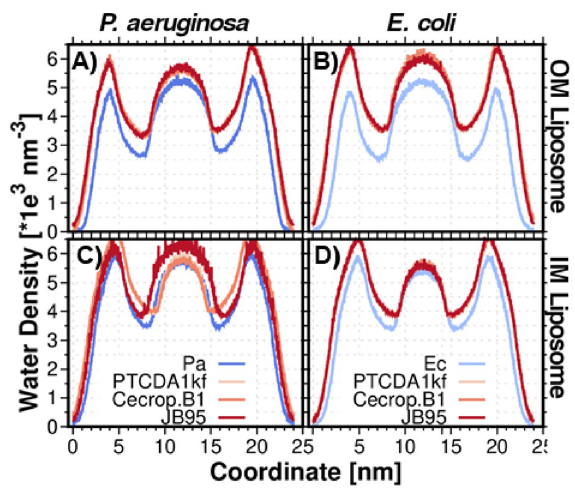
Figure 9. Water Density. ( A – B ) P. aeruginosa OM and IM liposomes, respectively. ( C – D ) E. coli OM and IM liposomes respectively. Analysis performed on the last μs of the MD